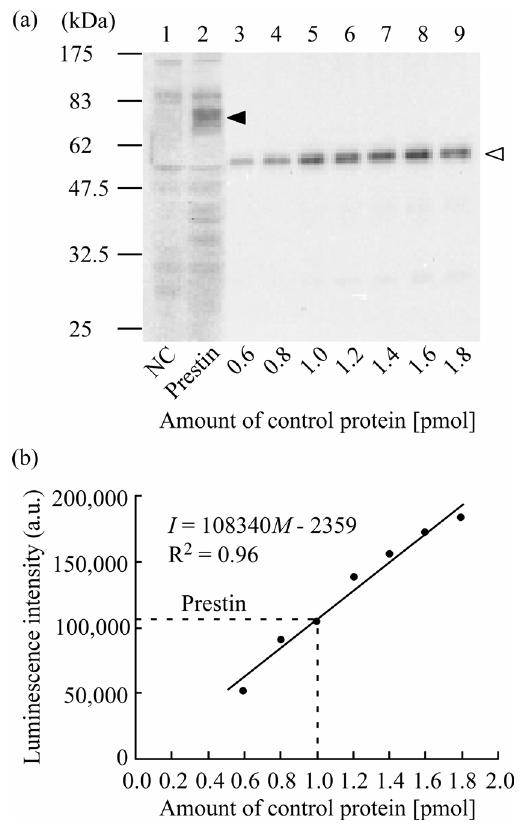
Fig. 5 Estimation of the amount of the prestin. (a) Result of Western blotting. Lane 1: uninfected cells (negative control). Lane 2: Infected cells. Lane 3–9: 0.6–1.8 pmol of control proteins. Solid and open arrowheads show prestin and positive control proteins, respectively. (b)Relationship between the amount of protein and the luminescence intensity of the bands for control proteins and prestin. The solid line represents the regression line ( I = 108340 M – 2359; R 2 = 0.96). The dashed line represents the net intensity of the band showing prestin. Based on the intersection of the regression line with the dashed line, the amount of prestin was determined to be 1.0